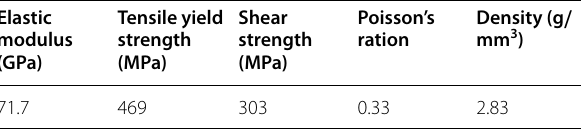
Table 1 Mechanical properties of 7050-T7451 aluminum